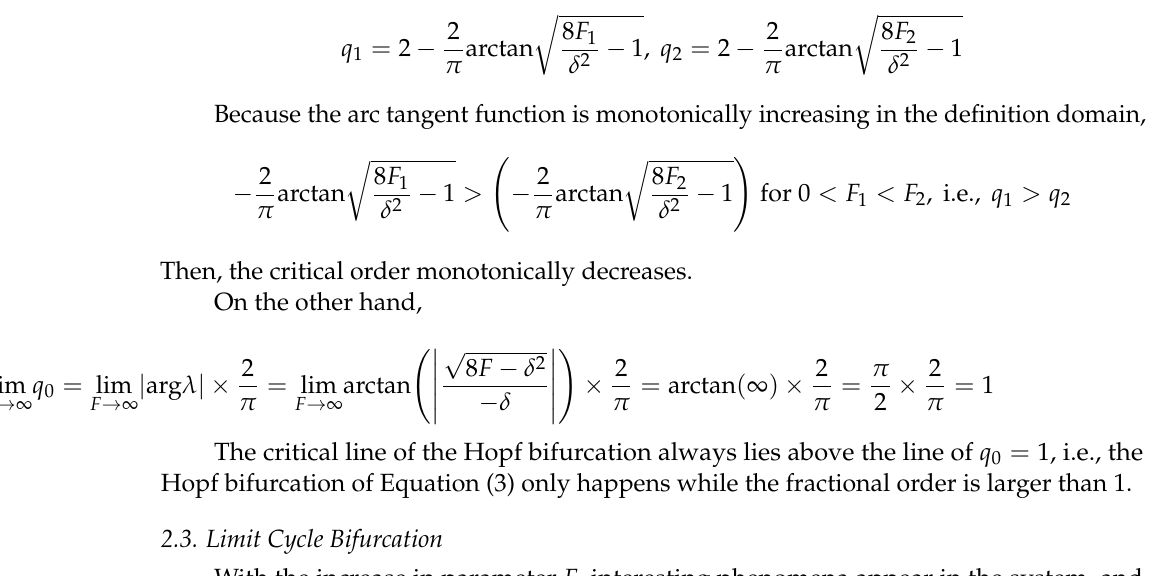
(cid:16) −√ (cid:17)   ,0 F  . F ,0